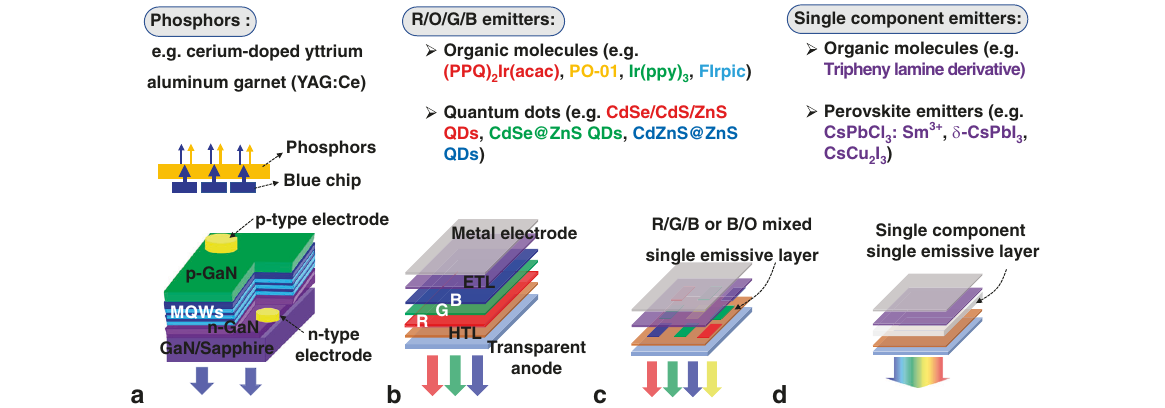
Strategy 1: Exciton recombination regulation by doping host with R/G/B guests